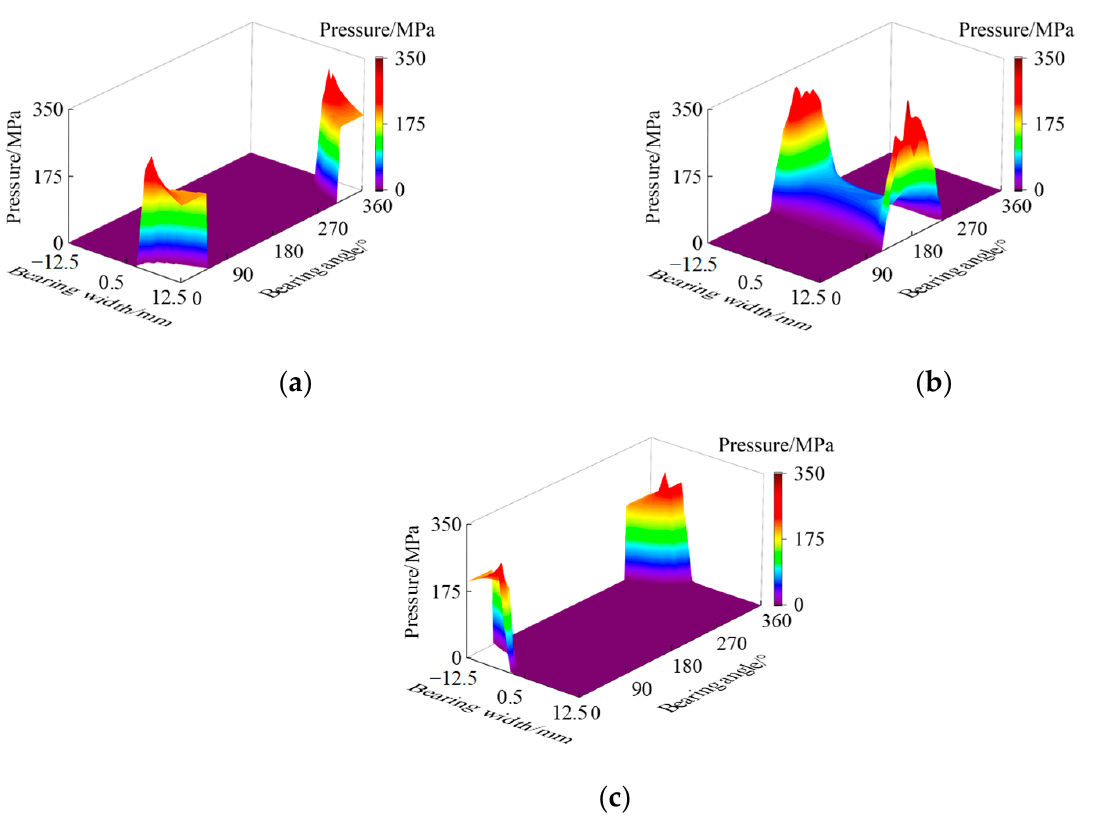
Figure 9. ( a ) Oil film pressure distribution in left piston pin boss. ( b ) Oil film pressure distribution in small-end bushing. ( c ) Oil film pressure distribution in right piston pin boss.